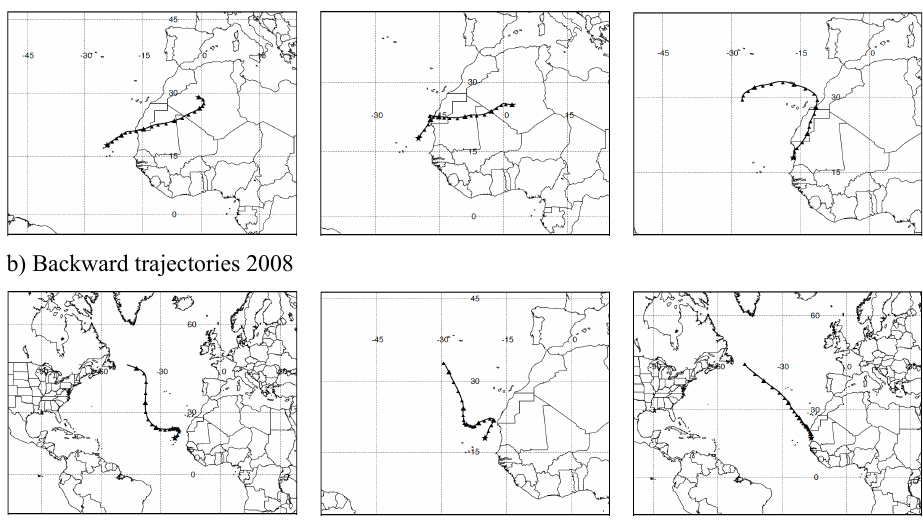
Fig. 3. Backward trajectories (HYSPLIT), 120h for representative sampling locations along the 18 ◦ N transect: (a) POS 348 (2007) and (b) L’Atalante